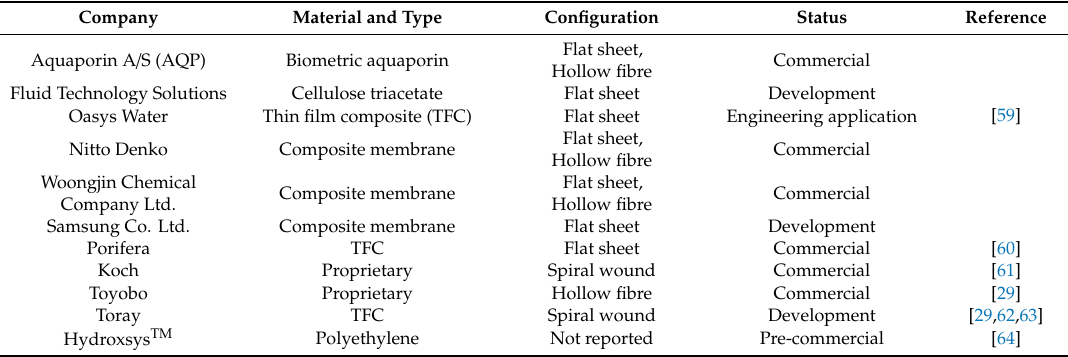
Table 3. Indicative status of FO membranes